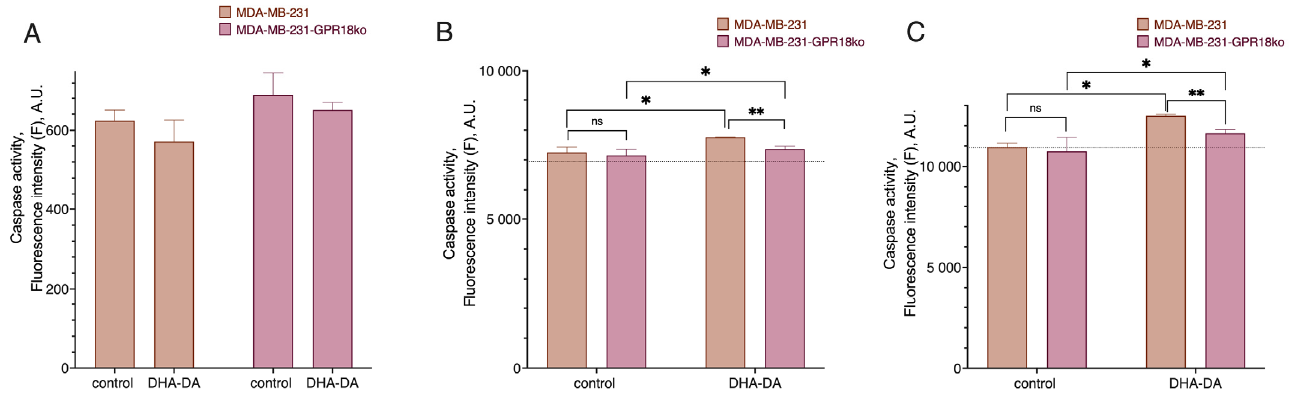
Figure 13. Effect of DHA-DA (40 µ M) on the caspase activation in the MDA-MB-231 cell line after Int. J. Mol. Sci. 2023 , 24 , x FOR PEER REVIEW